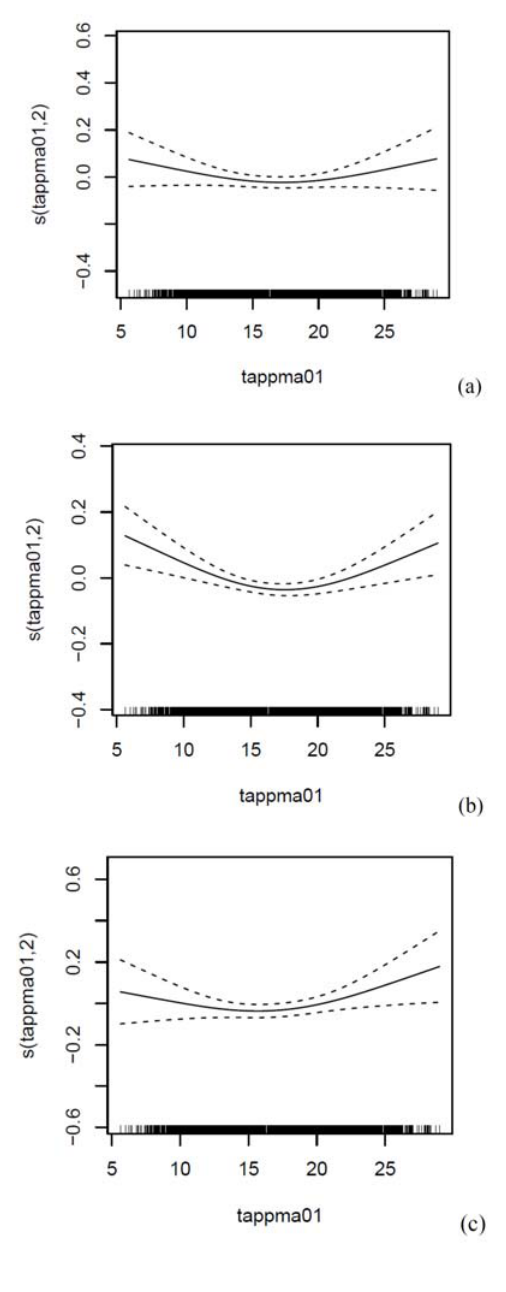
Figure A8. Smoothed relationship between the 2-day cumulative average of Tapp (entire year) and ( a ) RD, ( b ) CVD and ( c ) CBD mortality in Cape Town, South Africa during 2001–2006. Adjusted for the 2-day cumulative average of PM term seasonal trends, public holidays, day of the week, 2-day cumulative averages of 24-h wind and rain. K = 3 for Tapp, K = 30 for time, i.e.